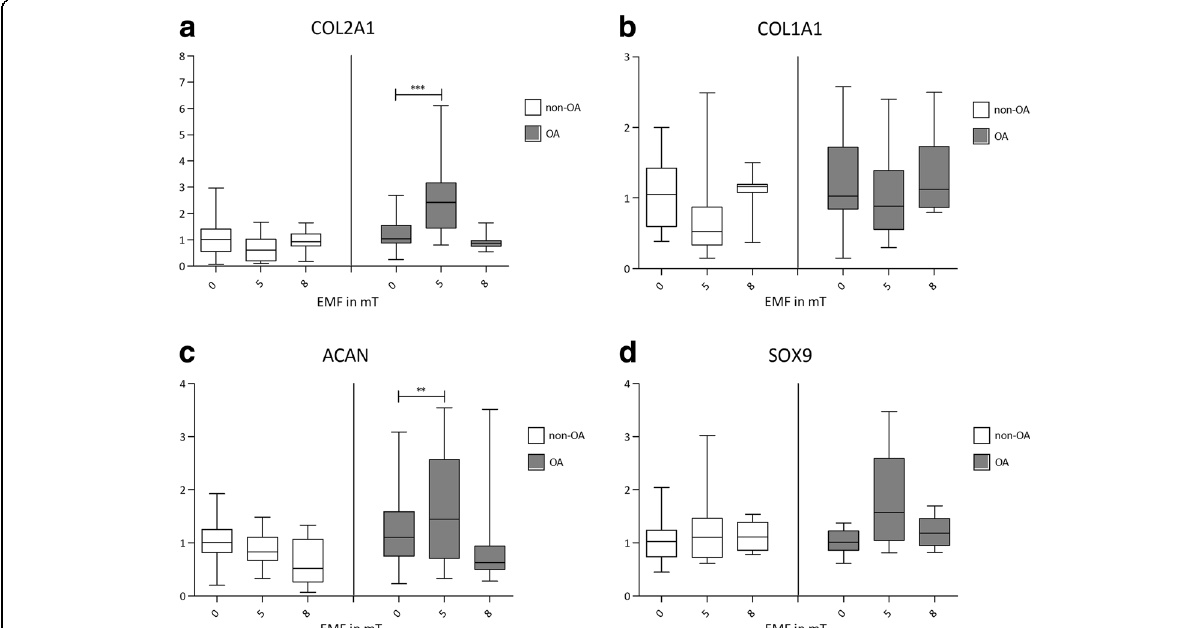
Fig. 3 Alteration of normalized gene expression of COL2A1 ( a ), COL1A1 ( b ), ACAN ( c ) and SOX9 ( d ) to GADPH expressed by pellets of OA ( n = 12 with 5 mT and n = 9 with 8 mT) and non-OA patients ( n = 9 with 5 mT and 8 mT) after 7 days in a 5 mT or 8 mT EMF normalized to the respective